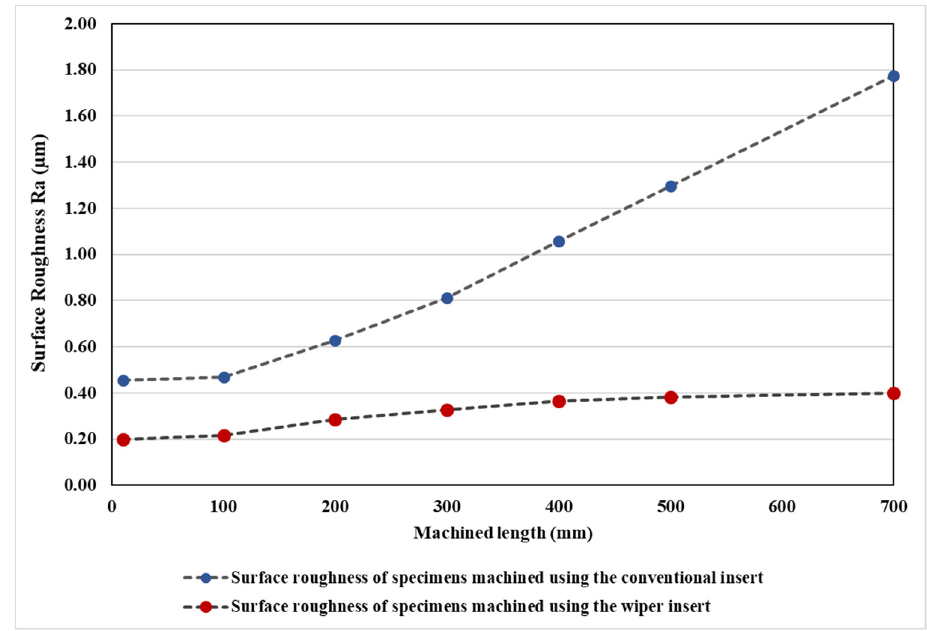
Figure 9. Comparison of the surface roughness for the conventional and wiper inserts at various machined lengths.